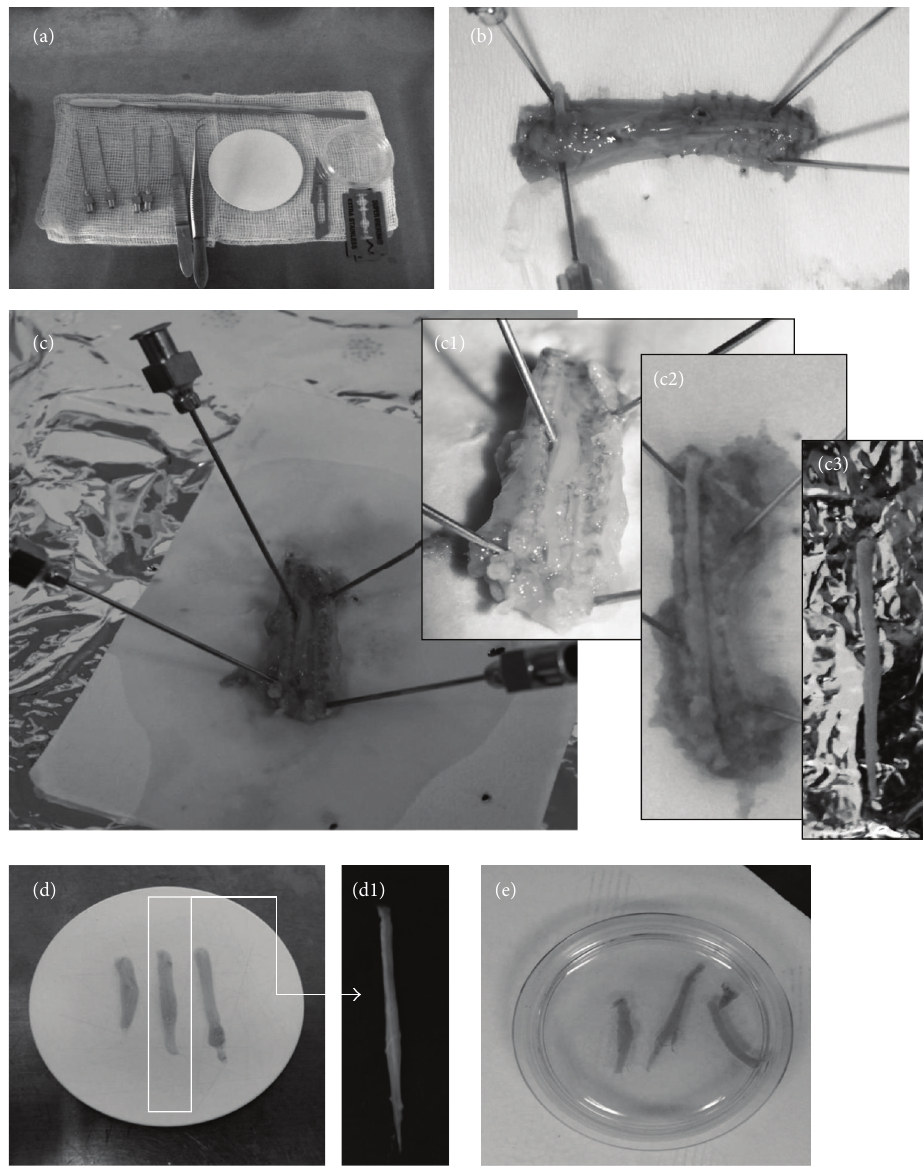
Figure 1: Illustration of sequential steps of organotypic spinal cord slices preparation. All needed for preparation tools (a) and the main steps of the spinal cord isolation were photographed. The incision of the entire spinal cord block from the dorsal side (b). Fixation with syringe needles spinal column (c). Progressive steps of spinal cord isolation (c1–3). The dissection of white spinal cords (d) and its magnification (d1). The transfer of spinal cord slices into the Millicell-CM (Millipore) membranes